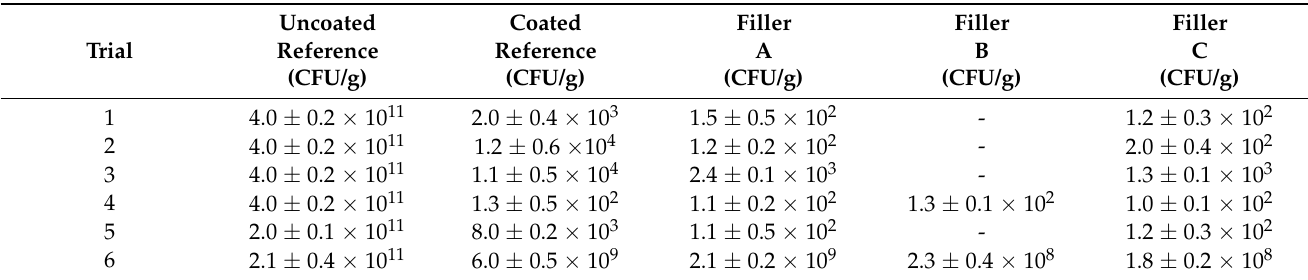
Table 6. Evaluation of the effect of filler solutions on the viability of coated and uncoated L. plantarum after 12